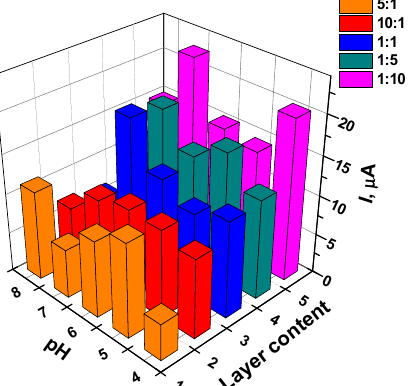
Figure 3. The dependence of the anodic peak current on the GCE covered with the mixture of the CB and AY on the surface layer content and the pH. The surface layer content is expressed as v:v ratio of the components mixed prior to deposition on bare GCE. 1—5:1, 2—10:1, 3—1:1, 4—1:5, 5—1:10 (the numbers also correspond to appropriate lines of Table S1).